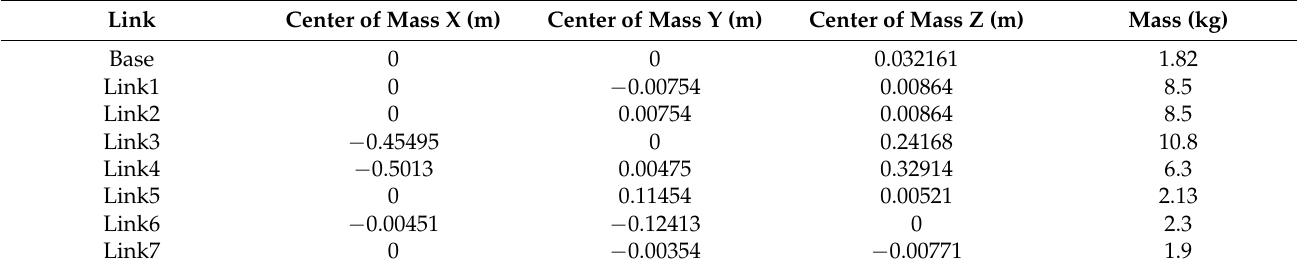
Table 2. Inertial parameters of the space